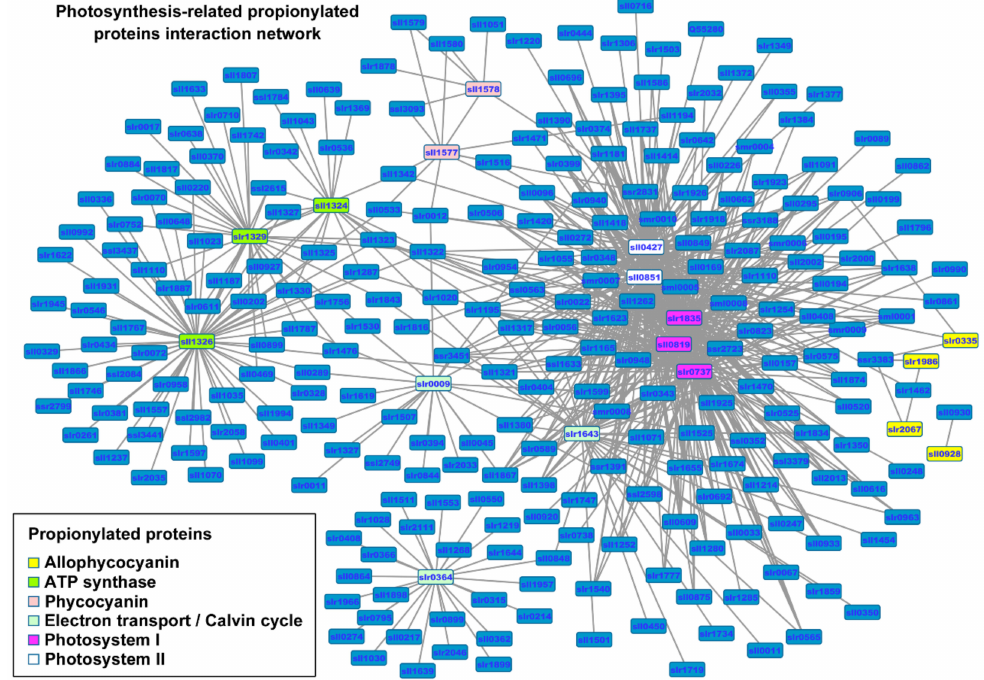
Figure 3. The complete interaction network of identified propionylated proteins associated with photosynthesis in Synechocystis . The propionylated proteins involved in photosynthesis are grouped using associated subcellular localizations and highlighted in di ff erent